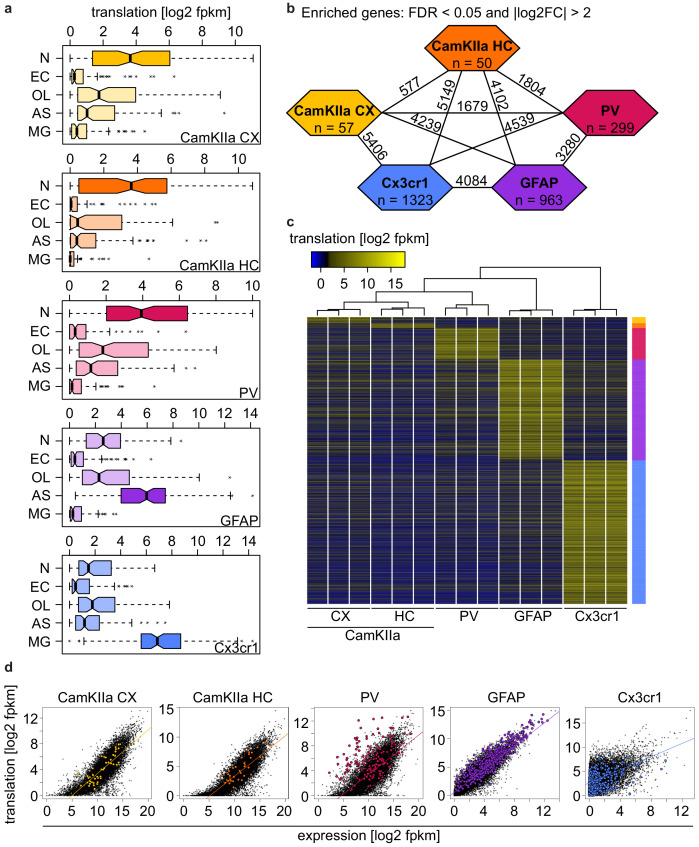
Identification of preferentially translated transcripts in different cell types.(a) Boxplots displaying the translation (log2 transformed fpkm values) of the top 100 genes in neurons (N), endothelial cells (EC), oligodendrocytes (OL), astrocytes (AS) and microglia (MG) in the indicated cell type. Boxes containing genes expected to be highly translated are shaded in a darker tone. (b) Identification of genes that were differentially translated (|log2FC| > 2 and FDR < 0.05) between two different cell types (numbers on lines) and of preferentially translated genes (PTGs) that were differentially translated in one versus all other cell types (numbers in colored hexagons). (c) Heatmap displaying the translation (log2 transformed fpkm values) of 2692 PTGs, revealing a clustering of samples according to cell type. (d) Scatterplots comparing the translation (log2 transformed fpkm values) and the expression (assessed via ribosome immunoprecipitation followed by sequencing; log2 transformed fpkm values) in the indicated cell type. Translation and expression of CamKIIa- and Cx3cr1-positive cells were assessed in corresponding brain regions. In contrast, PV and GFAP translation was examined in the whole brain, whereas PV expression was analyzed in neocortex and GFAP expression corresponds to the averaged expression across multiple regions (motor/somatosensory/visual cortex, cerebellum and hypothalamus). Linear regression lines are indicated and PTGs in the respective cell types are colored.